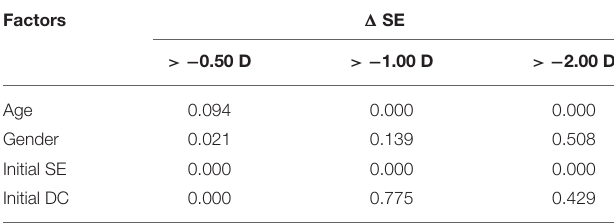
TABLE 5 | Correlation analysis for the risk factors and the change of SE.